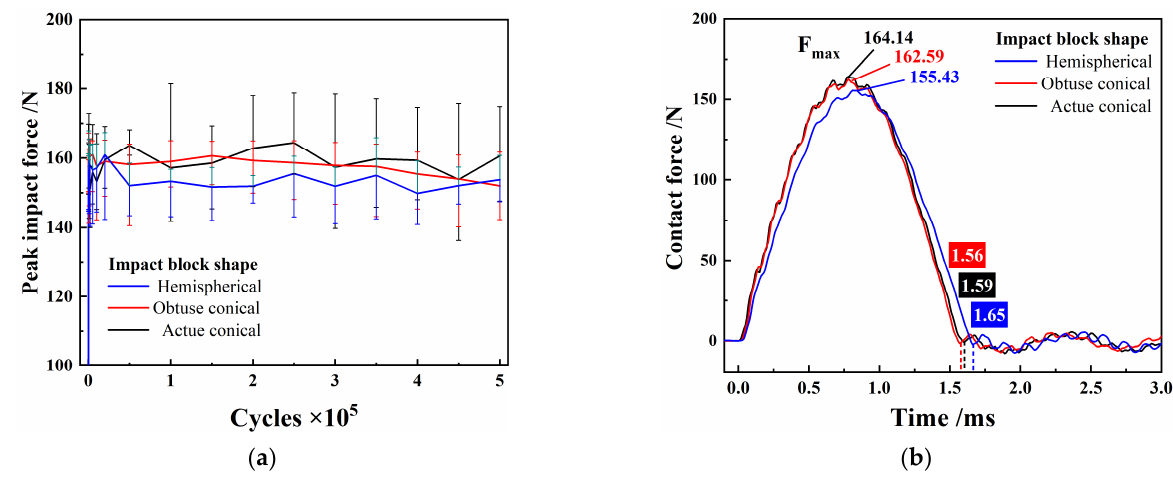
Figure 3. Curve of impact contact force with different impact block shapes, N = 5 × 10 5 . ( a ) Impact contact force vs. cycle; ( b ) impact contact force vs. time. contact force vs. cycle; ( b ) impact contact force vs.